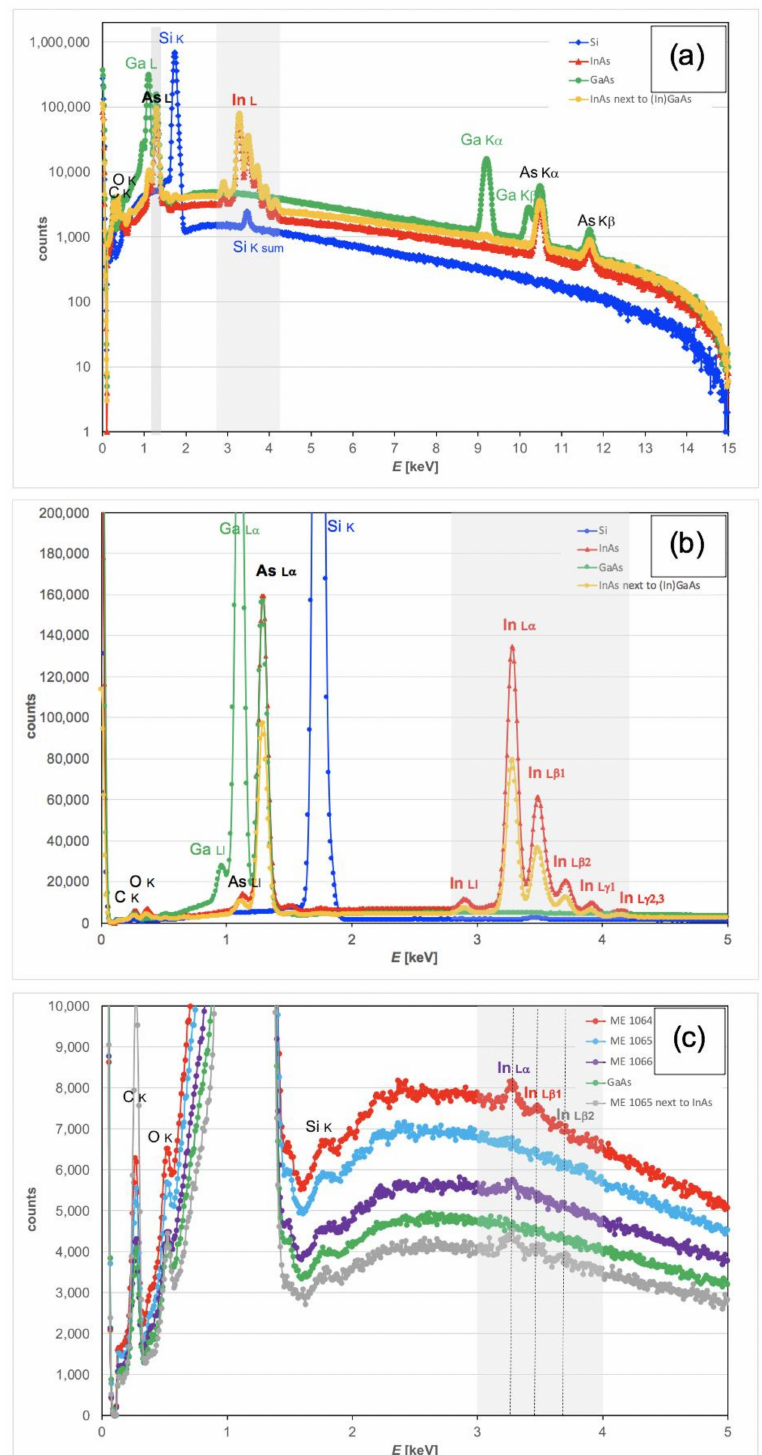
Figure 7. X-ray spectra from InAs, GaAs, Si and three InGaAs/GaAs wafer samples, displayed on a logarithmic scale for the energy range of 0–15 keV ( a ), on linear scale for the relevant range of 0–5 keV only, using different vertical scales to show the strong In L and As L lines ( b ) and the weak In L signals in the epitaxial wafer samples ( c